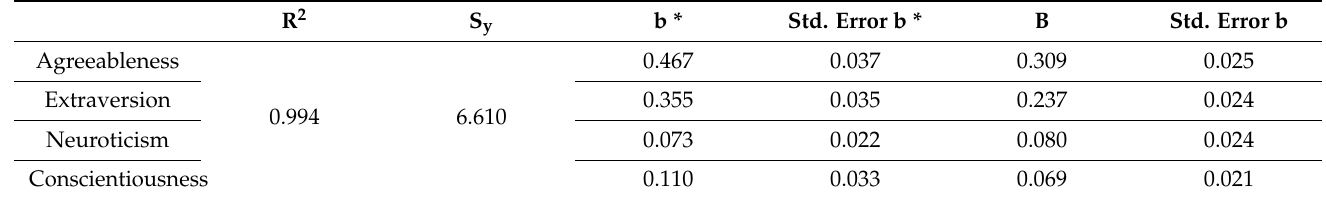
Table 5. Relationships between the personality traits of the Big Five model and the overall index of rational nutritional behaviours among athletes training in team sports (multiple regression